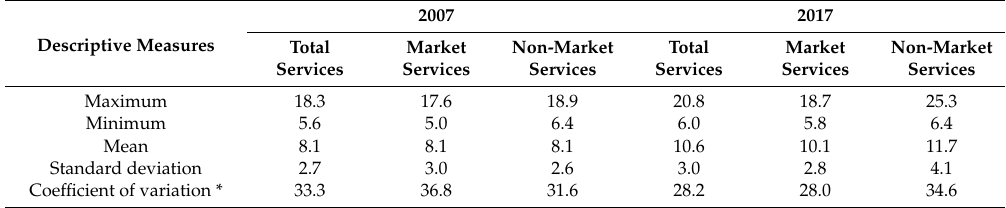
Table 1. Descriptive measures for services and their large groups, 2007–2017.